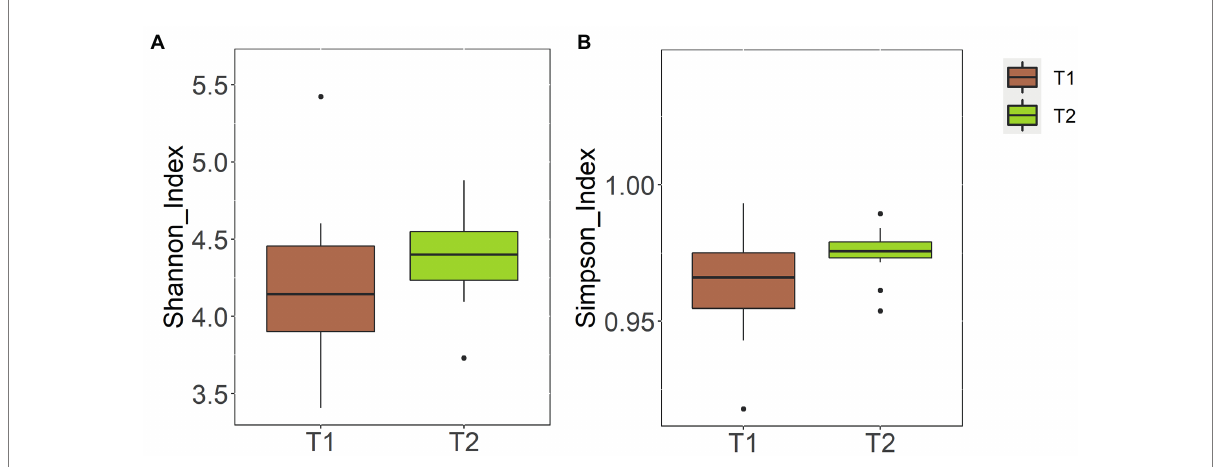
FIGURE 3 Alpha diversity at the ASV level of the fecal samples obtained at day 0 (T1) and at day 120 (T2). (A) Shannon diversity index; (B) Simpson diversity index.